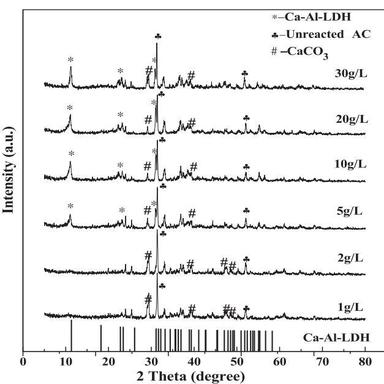
The XRD patterns of products with different dosage of AC and Ca (OH)2.